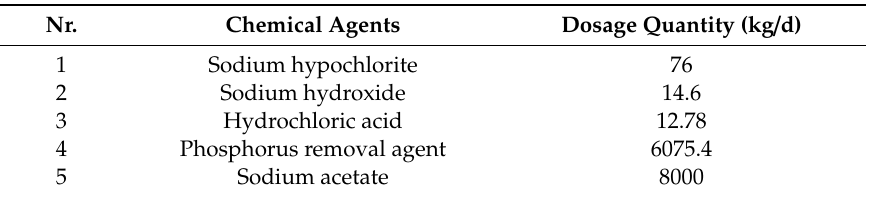
Table 6. Additional chemical consumption after